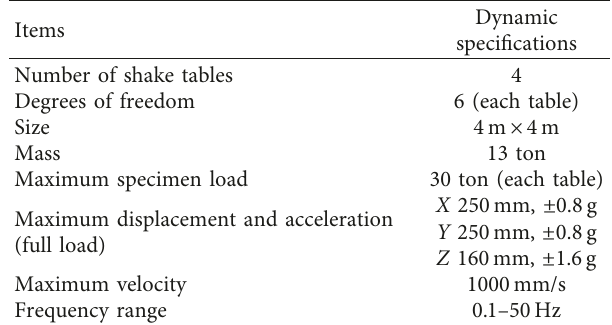
Figure 1: Shake table device’s important components. (a) Shake table and hydraulic actuator; (b) pump station, oil source, and control system. Table 1: The technical specifications of the shake table array at